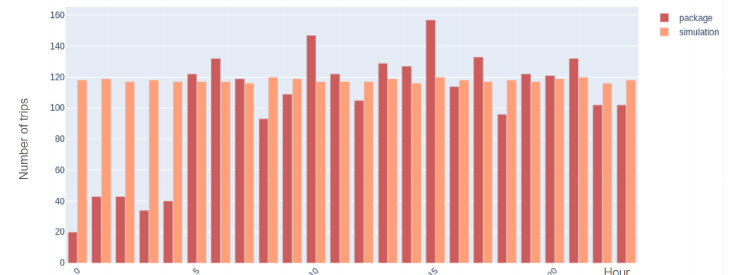
Figure 11. Comparison of hourly number of generated trips and the number of estimated trips by vehicle package.